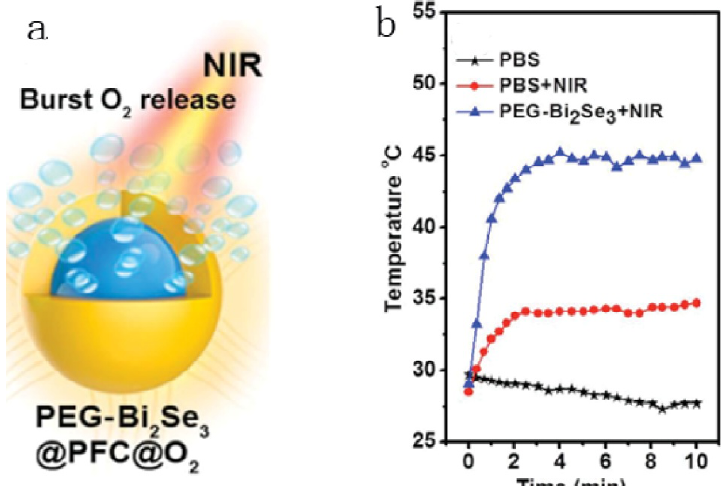
Fig. 5. (a) A Schematic showing burst release of oxygen from PEG-Bi an NIR laser. (b) Temperature changes of tumors monitored by the IR thermal camera during laser irradia- tion. Reprinted with permission from G. Song, C. Liang, X. Yi // Adv Mater 28 (2016) 2716. Copyright 2016 WILEY-VCH Verlag GmbH & Co. KGaA,